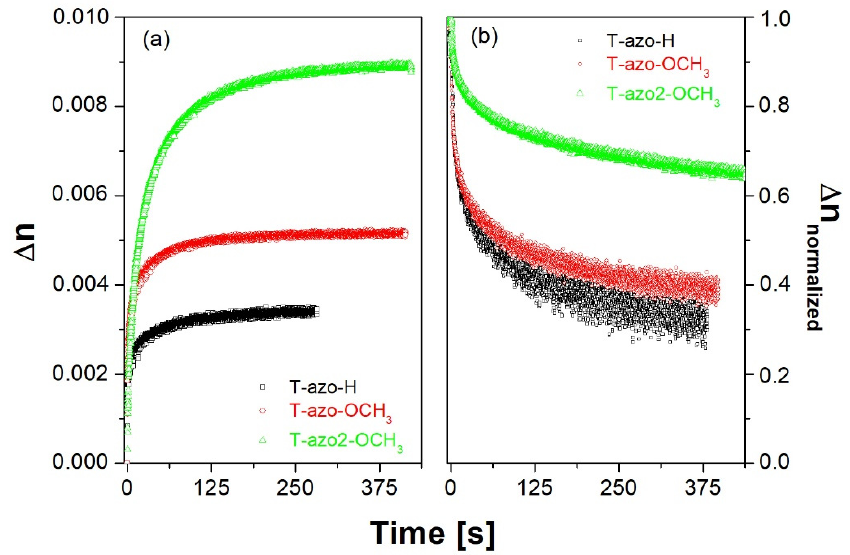
Figure 3. Birefringence ( a ) growth and ( b ) normalized relaxation curves for the thiazole–azo dyes dispersed in PMMA matrix thin films T–azo–OCH 3 , T–azo2–OCH 3 , T–azo–H ( λ exc. = 405 nm, λ probe = 690